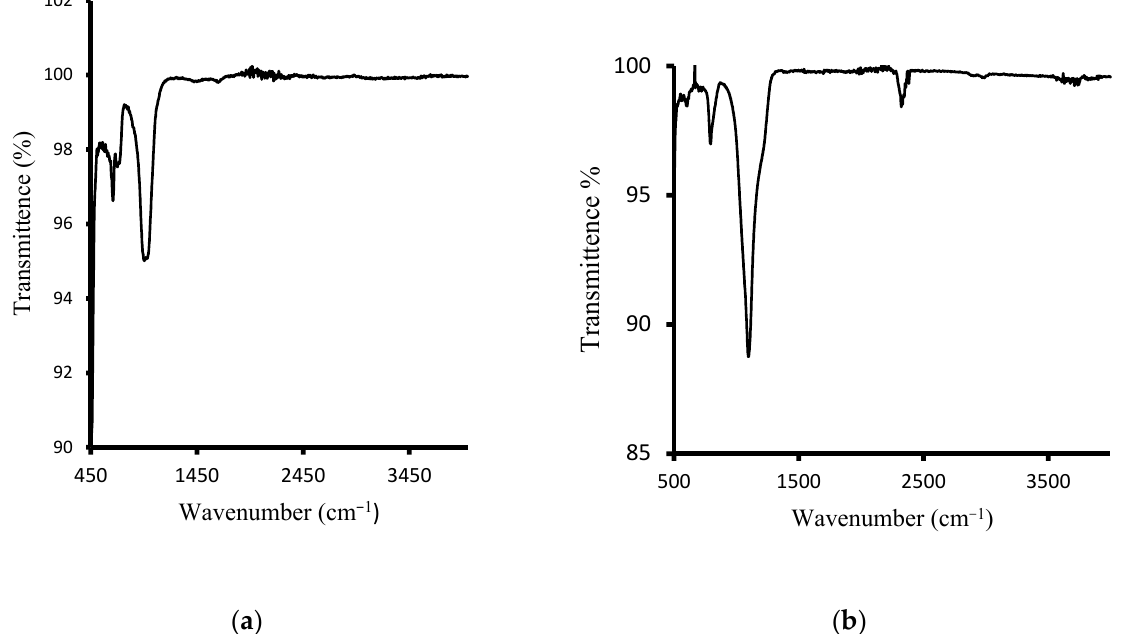
Figure 5. ( a ) Fourier Transform Infrared spectrum of HSOD crystals and ( b ) SSOD nanoparticles.